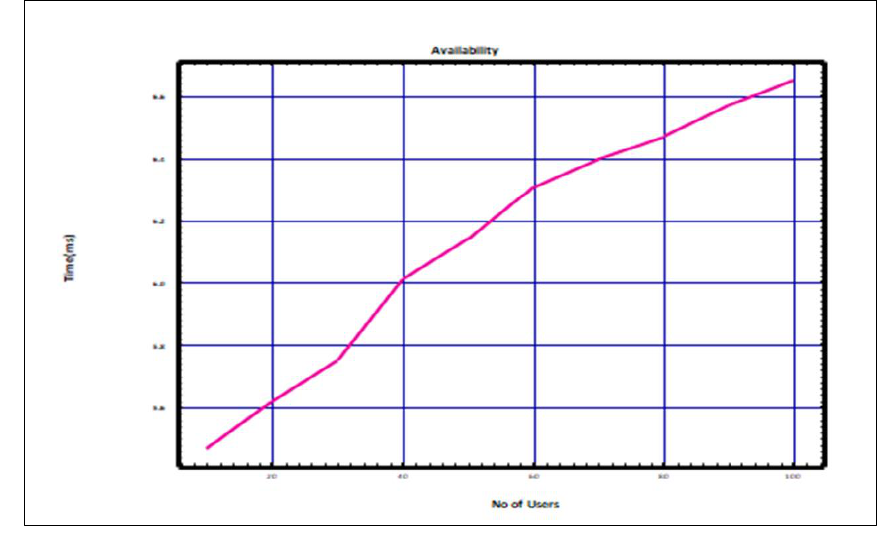
Figure 5: Graph of Availability.